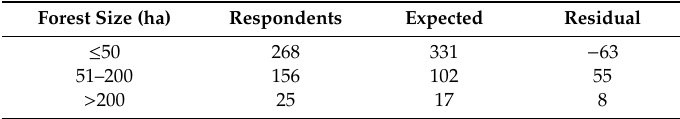
Table 3. Number of respondents according to size of forest holding, compared to the expected number of responses if they had been randomly distributed. Information was missing for one respondent.